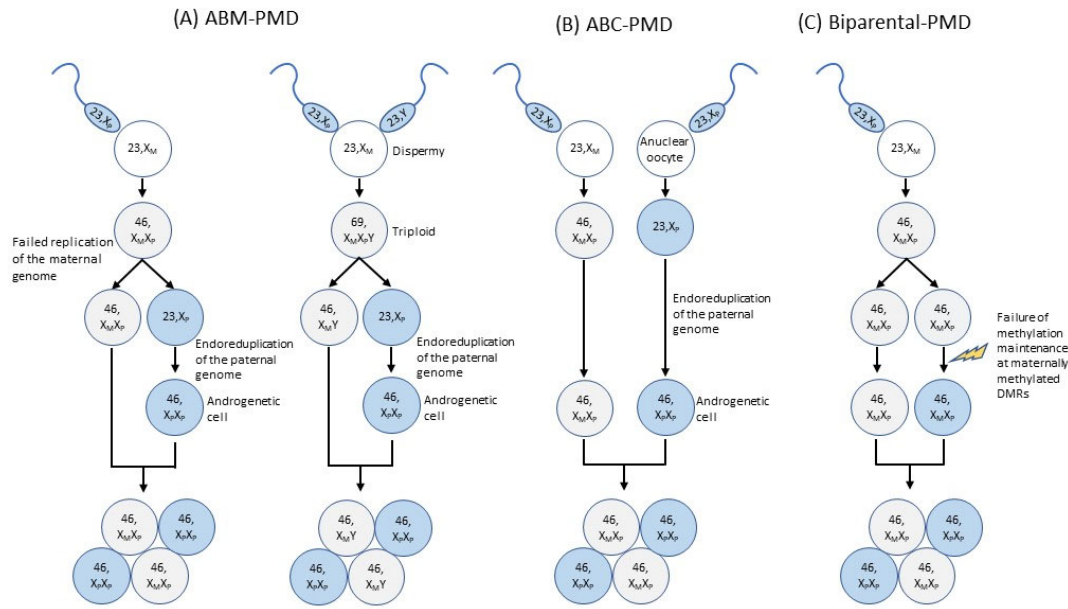
Figure 2. The etiologies of PMD. ( A ) Mechanism of PMD with androgenetic/biparental mosaicism (ABM). Left: Failure of maternal replication. ABM occurs when the zygote divides after the paternal genome has been replicated but the maternal genome has not. The daughter cell that carries only the paternal genome gives rise to androgenetic cells by way of endoreduplication of the paternal genome. Right: Dispermy. ABM occurs when a triploid zygote formed by two sperms and one oocyte divides without replication, giving rise to a (diploid) biparental cell and a haploid cell carrying only a paternal genome. The paternal genome is then endoreduplicated in the haploid cell, giving rise to androgenetic cells. ( B ) Mechanism of PMD with androgenetic/biparental chimera (ABC). ABC occurs when a normal zygote fuses with one created by the fertilization of an anuclear oocyte by a sperm cell. In the latter zygote, the paternal genome is endoreduplicated, giving rise to androgenetic cells. ( C ) Mechanism of biparental PMD. Normal fertilization is followed by normal cell divisions. Failure of methylation maintenance at maternally methylated differentially methylated regions (DMRs), including placenta-specific and ubiquitous DMRs, may occur during the postfertilization period, resulting in mosaicism of aberrantly and normally methylated cells.